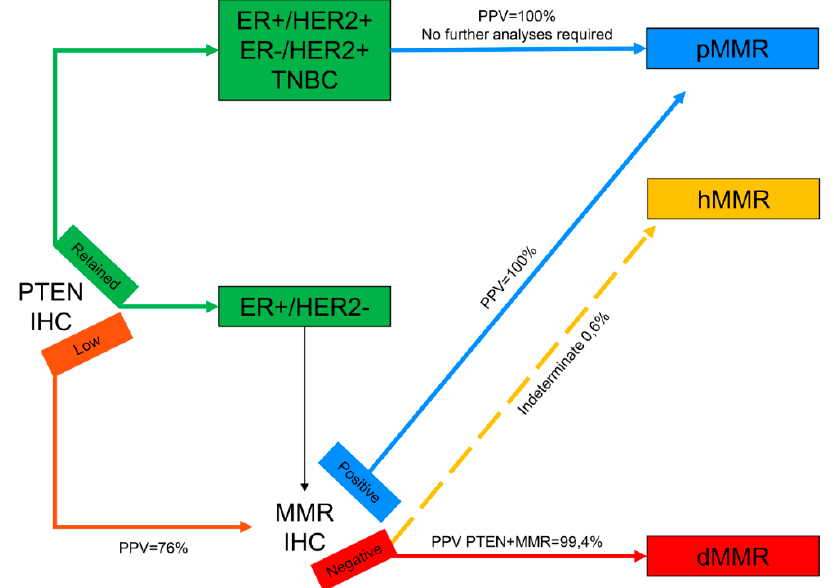
Figure 3. Revised diagnostic algorithm for the evaluation of mismatch repair status in breast cancer. Connectors drawn with continuous lines represent links between different steps of the diagnostic workflow; connectors drawn with discontinuous lines represent indeterminate biological characteristics. All connectors are color-coded based on the different biological features represented in the squared boxes. IHC, immunohistochemistry; ER, estrogen receptor; TNBC, triple-negative breast cancer; PPV, positive predictive value; MMR, mismatch repair; pMMR, mismatch repair proficient; hMMR, mismatch repair heterogeneous; dMMR, mismatch repair deficient.